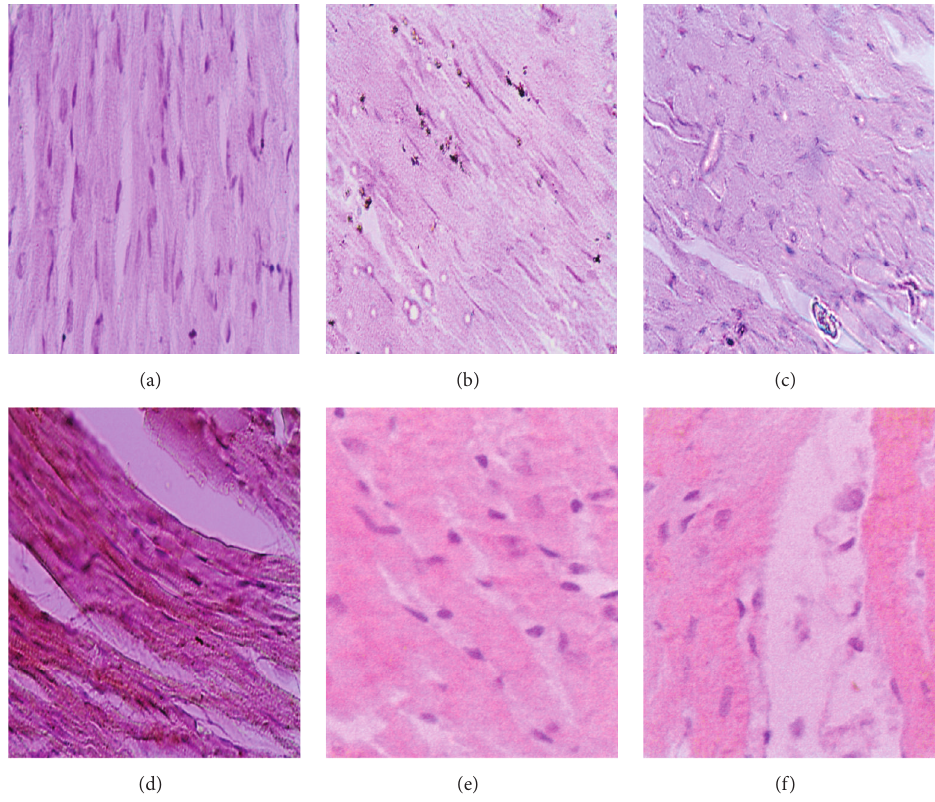
Figure 4: Photomicrography of caspase-3 immunostaining in the studied different animal groups. (a), (b), and (c) represent minimal expression sections from the control, metformin, and sitagliptin groups, respectively. (d) represents high caspase-3 expression found in the DOX group. (e) and (f) represent significantly lower caspase-3 expression found in the metformin/DOX and sitagliptin/DOX groups, respectively, as compared to (d). DAB was used as a chromogen and haematoxylin as nuclear and counter stain. Magnification used is